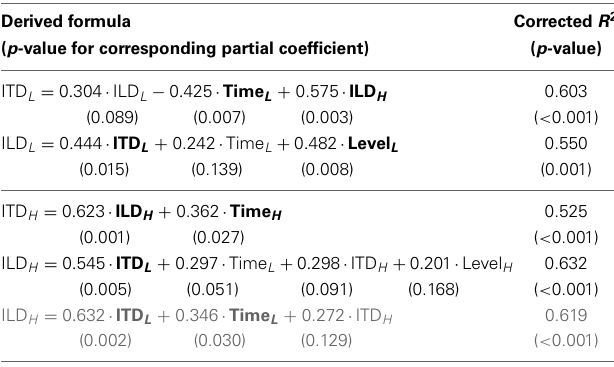
Table 2 | Summary of multiple regression analyses on all tasks. Derived formula Corrected R 2